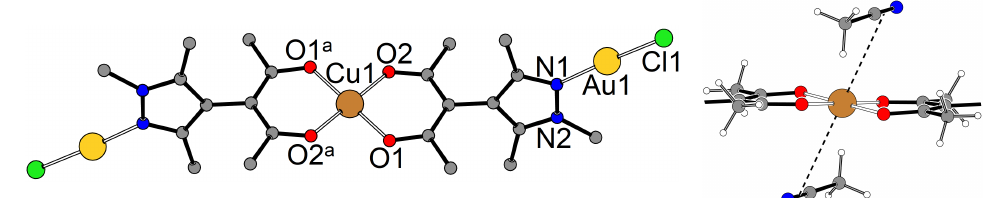
Figure 4. Left: PLUTON plot [33] of the discrete complex in 3 · 2MeCN (solvent MeCN omitted). Right: Coordination sphere around Cu1 with side-on coordinated solvent MeCN molecules. Selected intramolecular distances and angles (Å, °): Au1–Cl1 2.2458(19), Au1–N1 2.010(6), Cu1–O1 1.883(5), Cu1–O2 1.896(5), Cl1–Au1–N1 177.12(17), ω 71.7(4). Symmetry operation: a = 2 − x ,1 − y ,1 − z .